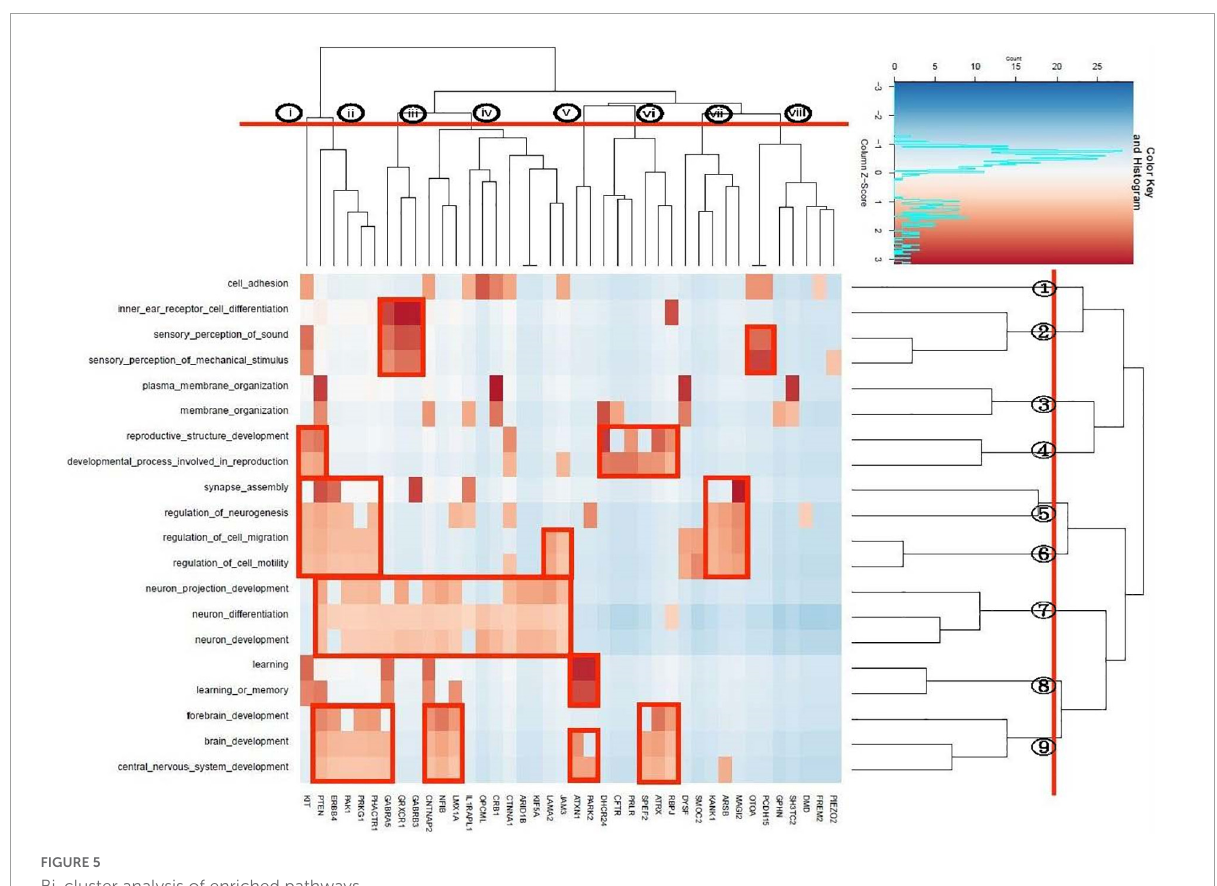
FIGURE5 Bi-cluster analysis of enriched pathways.